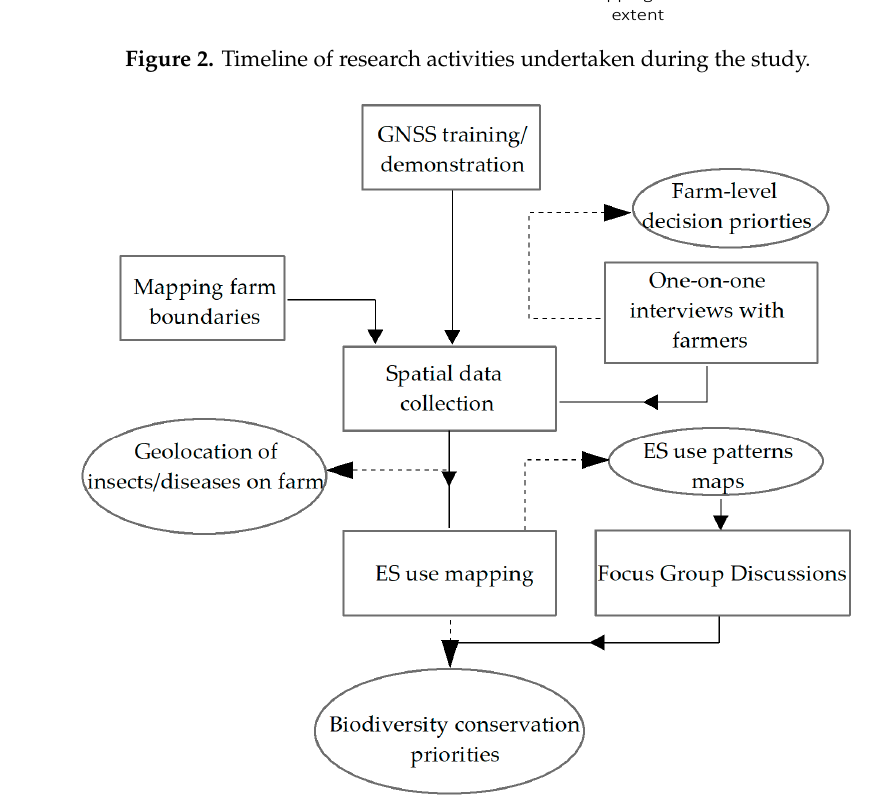
Figure 3. Flow chart of the research process. Dotted arrows to ovals represent outcomes of activities. Rectangles are activities engaged in while solid lines represent inputs to activities/next activity.